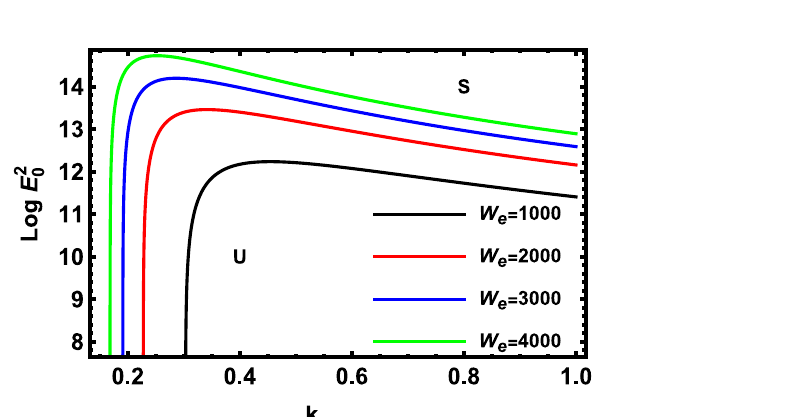
Figure 3. Displays the deviation of the growing amount against the wave numeral of numerous standards for the Reynolds Numeral R e .